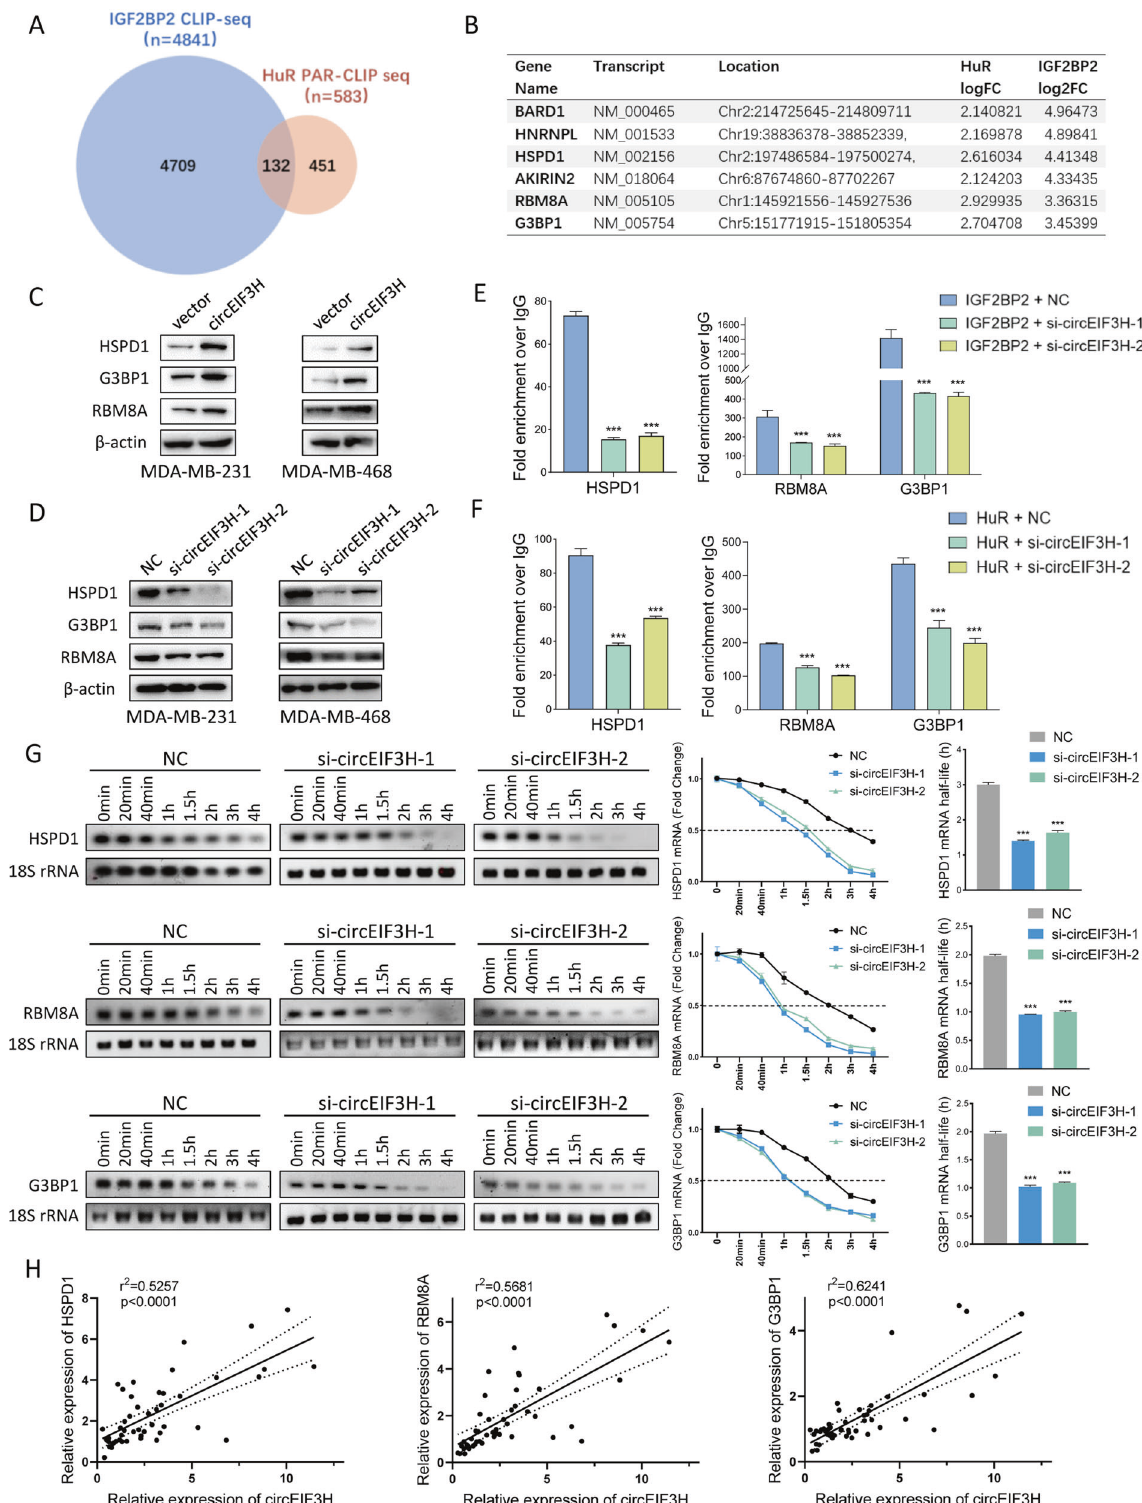
Fig. 4 CircEIF3H-IGF2BP2/HuR complex stabilized HSPD1/RBM8A/G3BP1 mRNA. A Venn diagram shows the RNAs interacted with IGF2BP2 (4709), HuR (451), or both (132). B Top transcripts interacted with both IGF2BP2 and HuR ware listed. C , D Expression levels of HSPD1/RBM8A/ G3BP1 after circEIF3H knockdown ( C ) or overexpression ( D ) were detected by Western blot. E , F RIP assays showed the enrichment of HSPD1/ RBM8A/G3BP1 with Flag-tagged IGF2BP2 ( E ) or HuR ( F ). G mRNA stability of HSPD1/RBM8A/G3BP1 was analyzed after si-circEIF3H transfection. H Correlation analysis of circEIF3H and HSPD1/RBM8A/G3BP1 expression analyzed by qRT-PCR in breast cancer tissues ( n = 49). The quantitative data were presented as mean ± SD. Statistical signi fi cance was determined by a two-sided Student ’ s t -test, *** P < 0.001. Cell experiments were repeated three times.